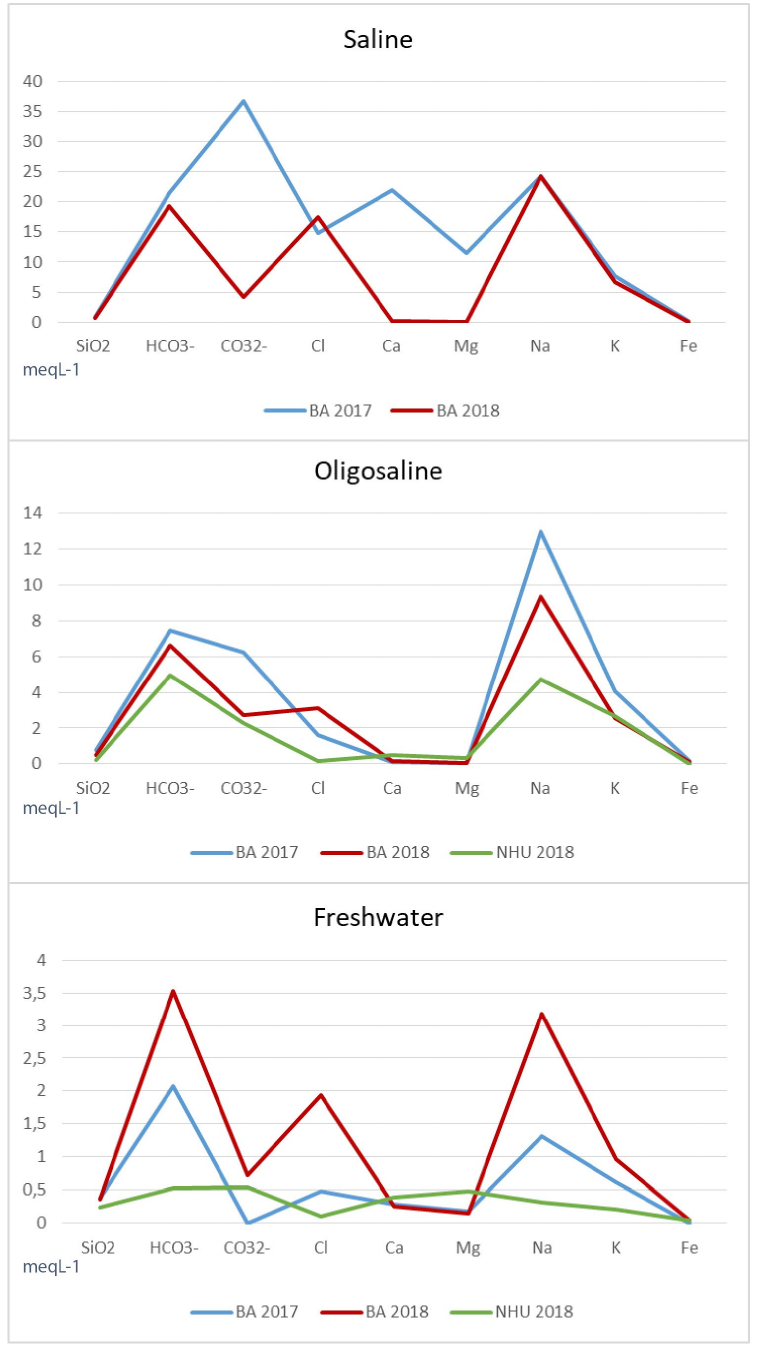
Figure 3. Distribution of the main elements in the saline, oligosaline and freshwater lakes from the three sampling campaigns. The values are given in meq L − 1 , except for SiO 2 , whose values are normally given in mmol L − 1 .